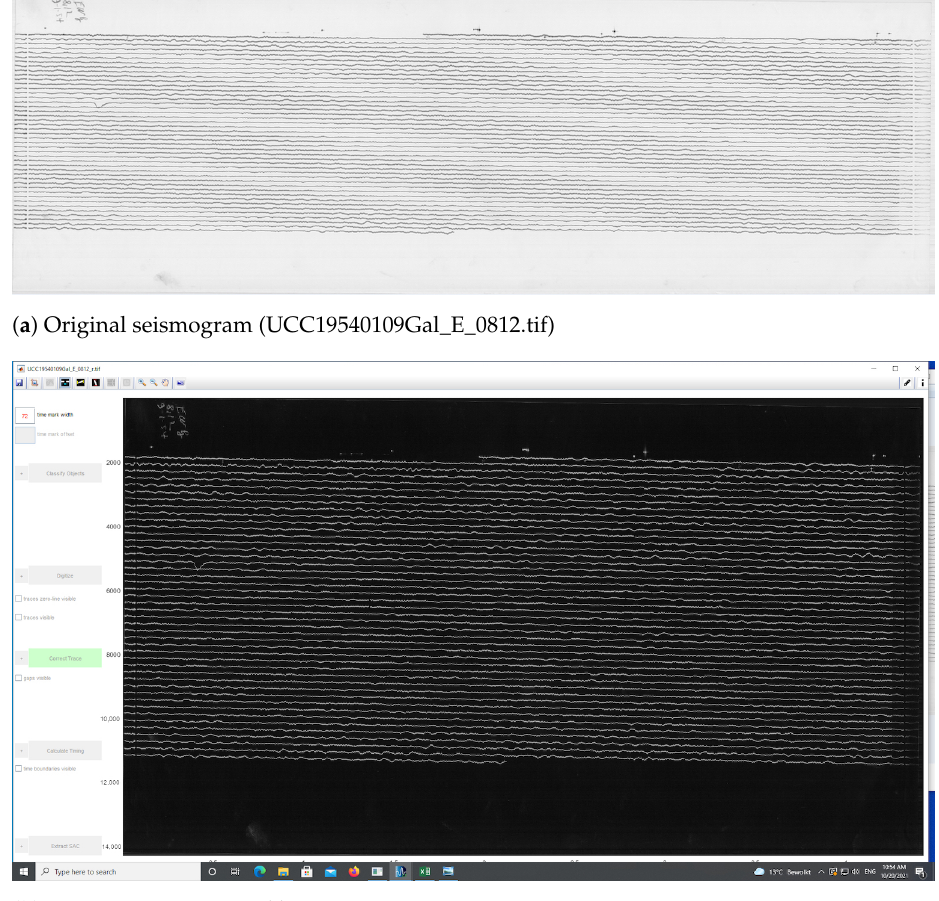
Figure 6. Seismogram recorded from Uccle station on 9 January